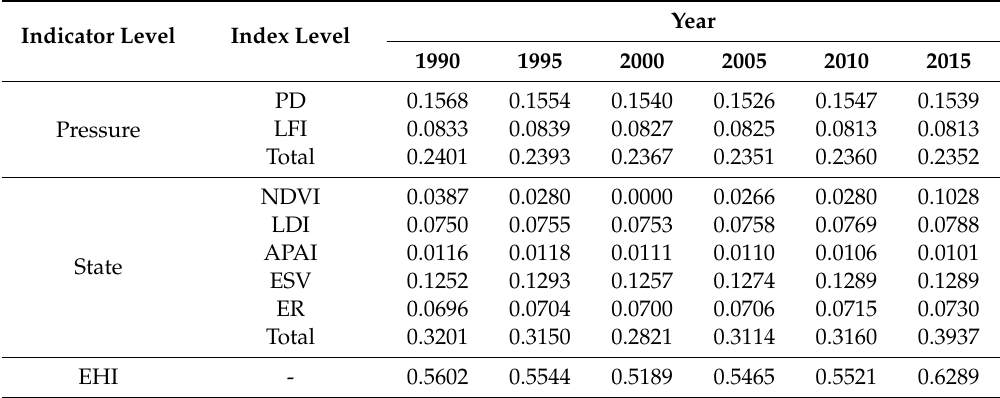
Table 3. Changes in di ff erent indices in the Pressure–State–Response (PSR) framework from 1990 to 2015 in the ESR at the region